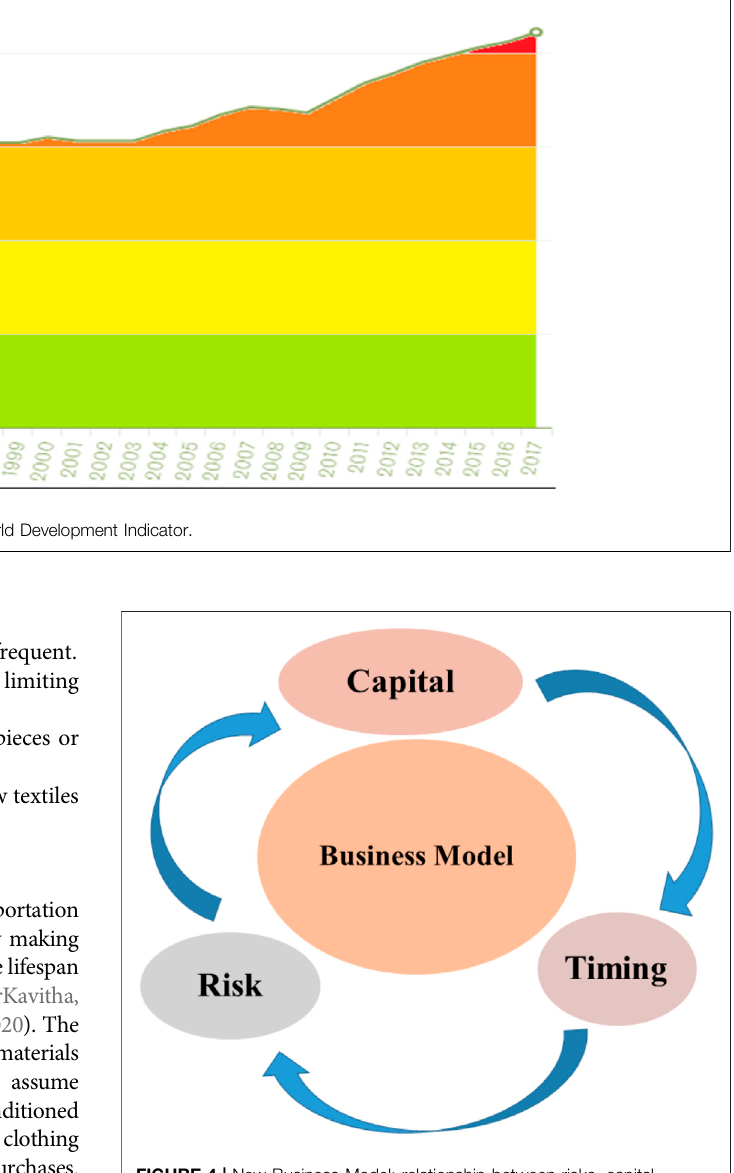
FIGURE 4 | New Business Model: relationship between risks, capital and